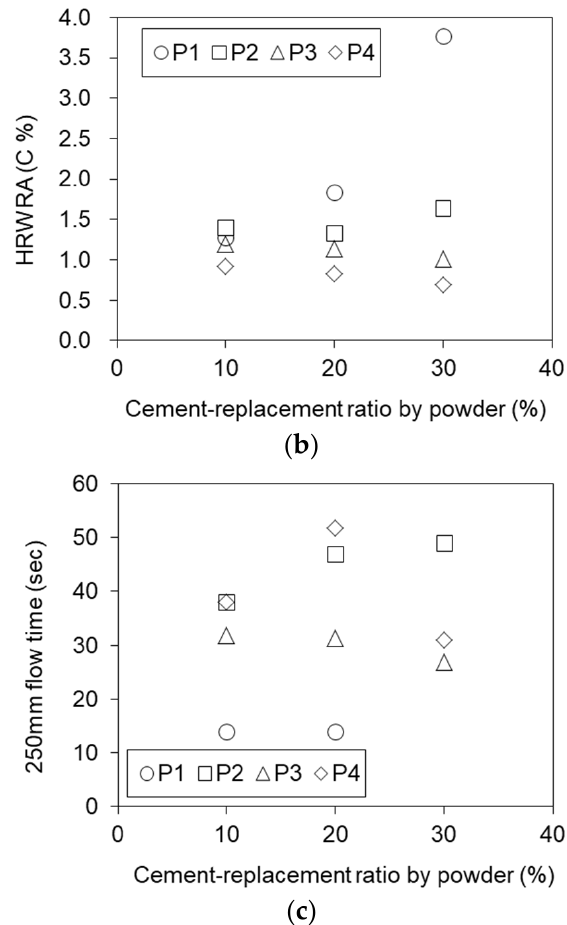
Figure 15. Effect of cement replacement ratio (P/B) by powder material. ( a ) P/B—mortar flow. ( b ) P/B—HRWRA. ( c ) P/B—250 mm flow time.